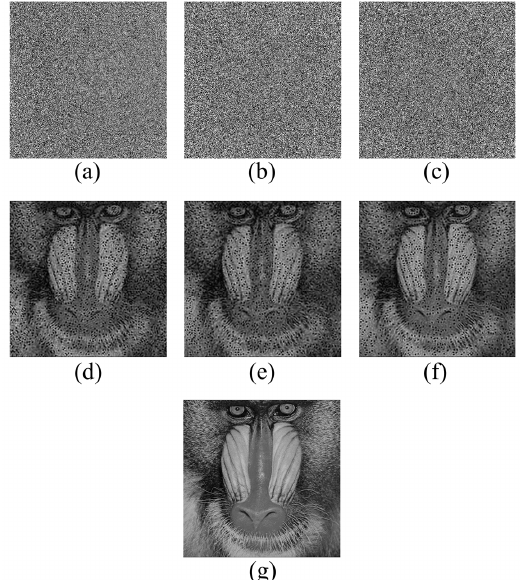
Figure 5. Off-axis BCGHs and the reconstructed images. The BCGHs are produced by DBS ( a ), SA ( b ), and SABS ( c ), respectively. Their reconstructed images are in ( d ), ( e ), and ( f ), respectively. ( g ) is the target image.